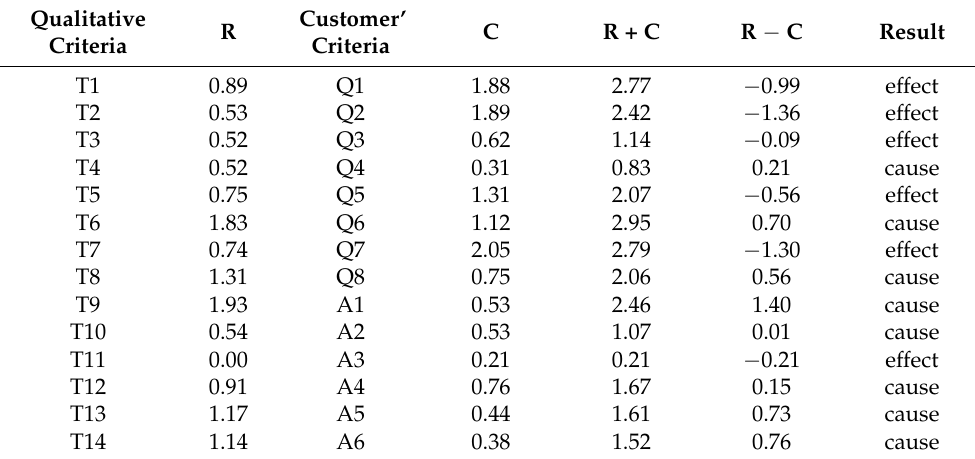
Table 4. Matrix of the total impact of PV criteria. Own